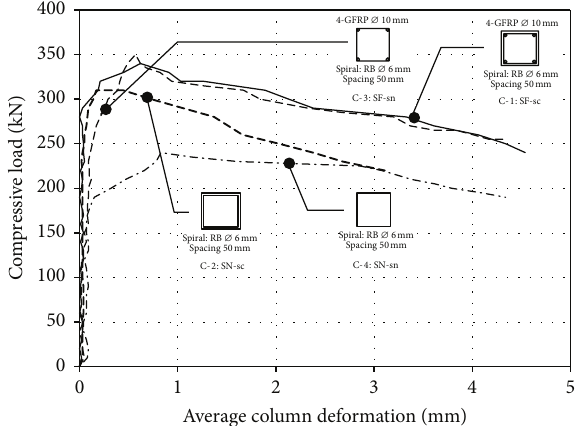
Figure 3: Load-deformation curves of rectangular specimens with spirals.